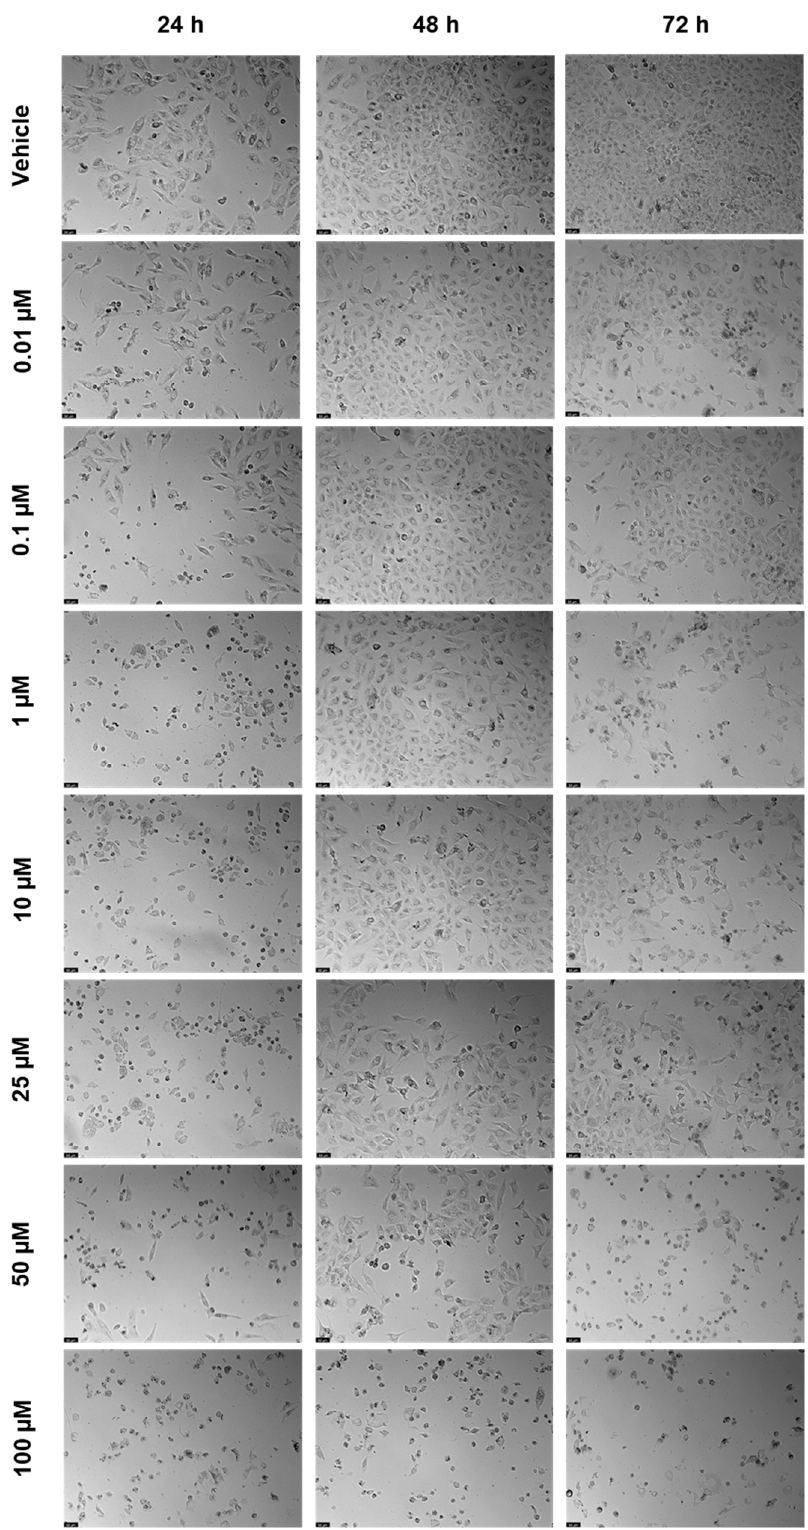
Figure 15. Morphological evaluation of A549 after exposure to increasing concentrations of saquinavir (0.01–100 μ M) for 24, 48, and 72 h. Control cells were treated with the vehicle (0.01% DMSO). These images are representative of three independent experiments. The scale bar is 200 μ M.